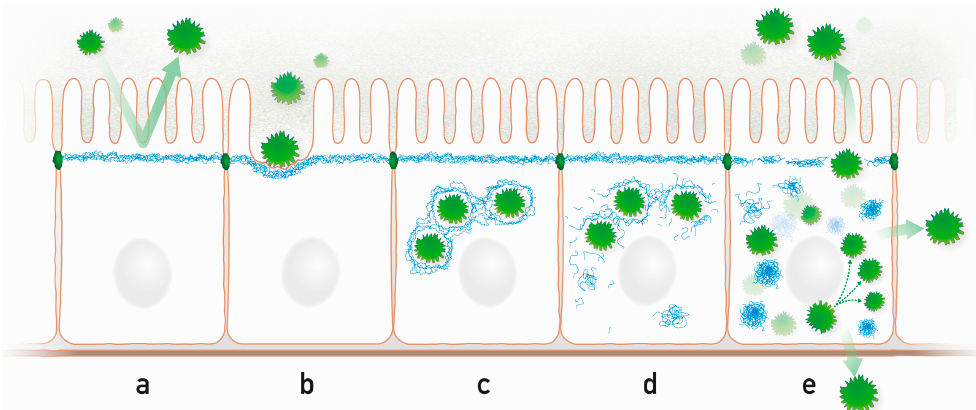
Figure 2. Highly schematic representation of processes that may occur during microbe-intermediate filament interaction in a simple epithelium. ( a ) The subapically enriched cytoplasmic IF system acts as an intracellular protective barrier; ( b ) IFs form together with the actin cytoskeleton pedestals for attached microbes; ( c ) Intracellular microbes are encaged by IFs; ( d ) Microbes disrupt the IF cage through kinase activities, which modify IF polypeptides and initiate the formation of cytoplasmic IF aggregates; ( e ) Released microbes proliferate and spread to neighboring cells and to the environment disrupting the protective apical IF network. Prominent cytoplasmic aggregates containing hyperphosphorylated IFs appear.